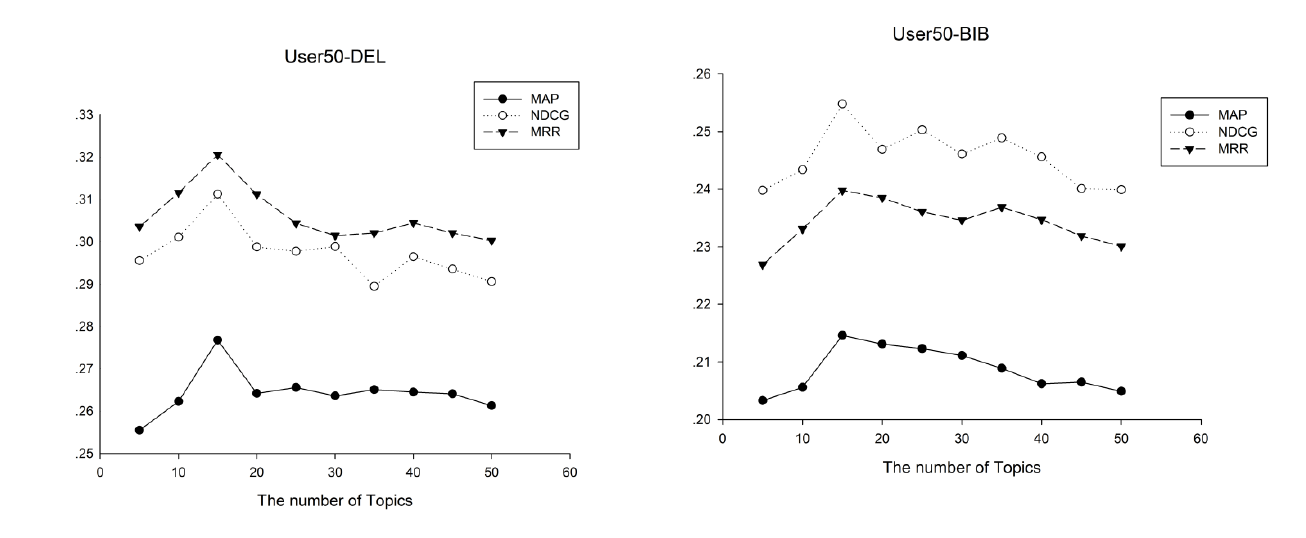
Fig. 3 . The performance by varying the number of topics on two corpora